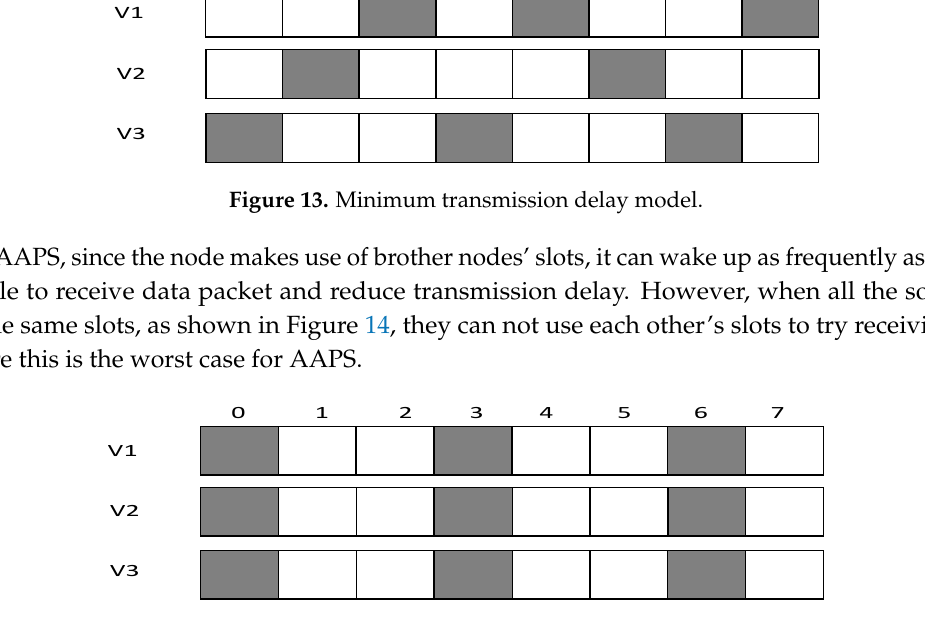
Figure 14. Model of son nodes’ having the same slots.